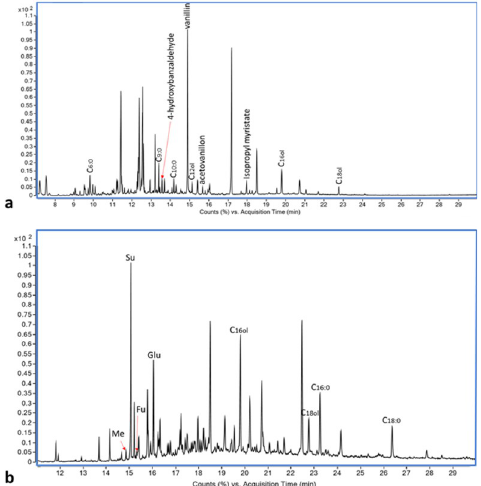
Fig 5. Chromatogram of vessel #170571 from structure 17049. a. Partial TLE Chromatogram of vessel #170571. b. Partial WM Chromatogram of vessel #170571. Cx:y = fatty acid with x carbons in its chain and y is the number of double bonds; Cxol = alcohol with x carbons in its chain; Me = maleic acid; Su = succinic acid; Fu = fumaric acid; Glu = glutaric acid. Derivatization information was omitted for clarity. For details see S3